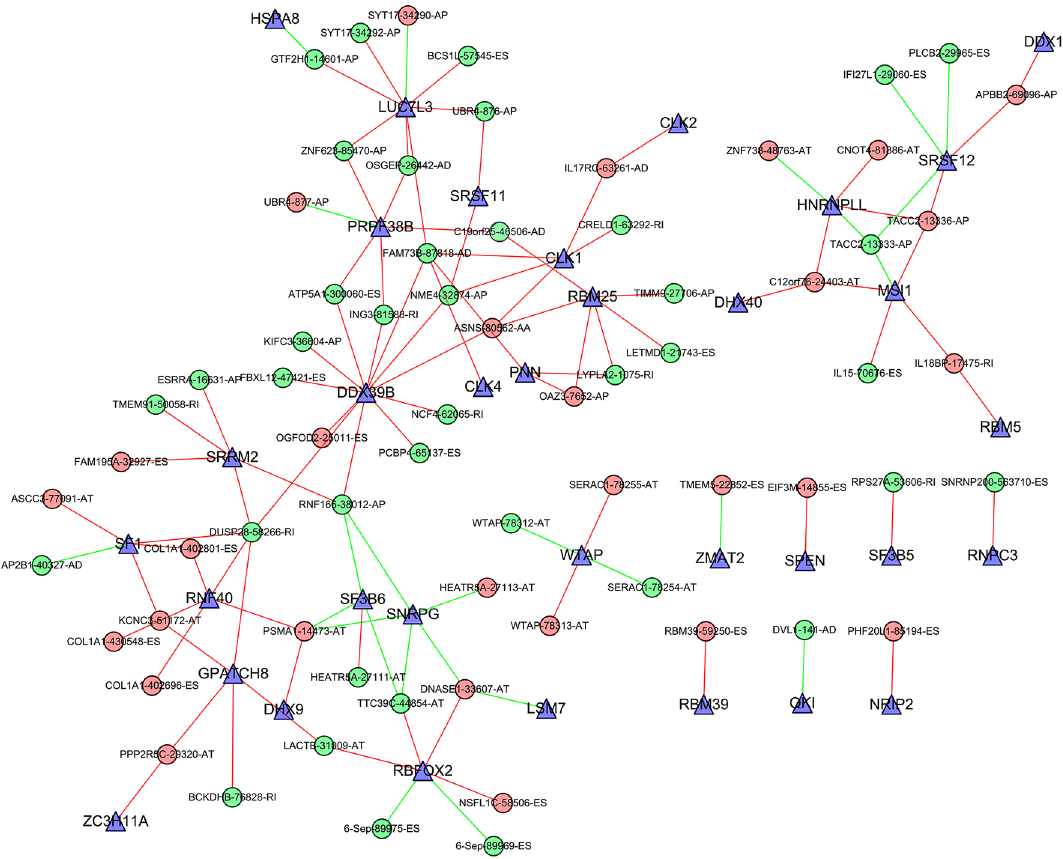
Figure 6. Splicing correlation network in ovarian carcinoma. AS events were negatively/positively associated with survival times representing with red/green dots, and blue triangles were survival-related splicing